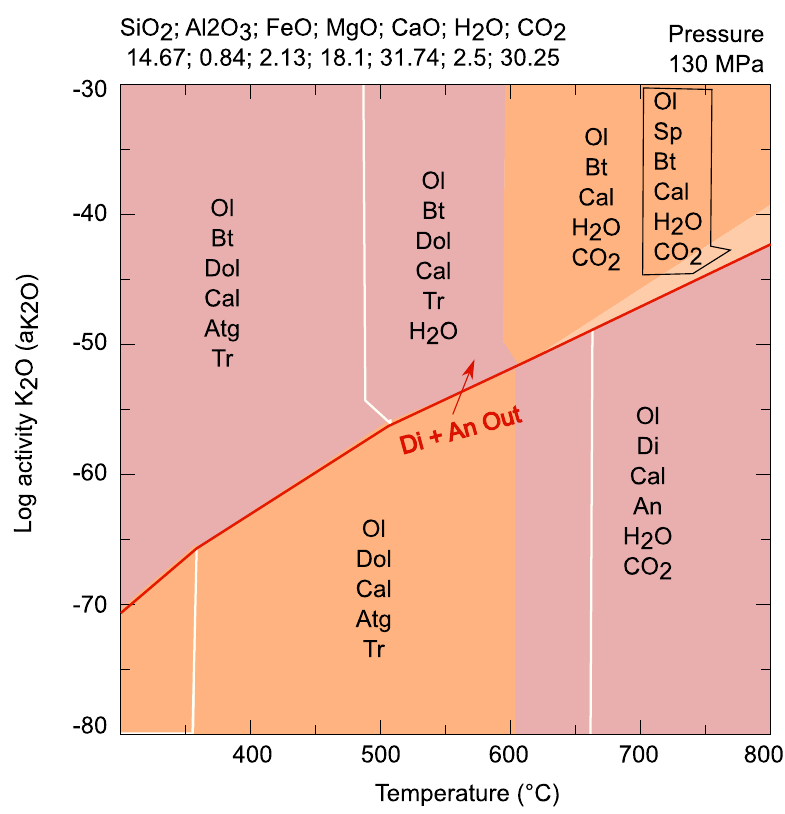
Figure 10. Log activity K 2 O-temperature pseudosection calculated at a pressure of 130MPa. Bulk chemistry used for the calculation is given above the